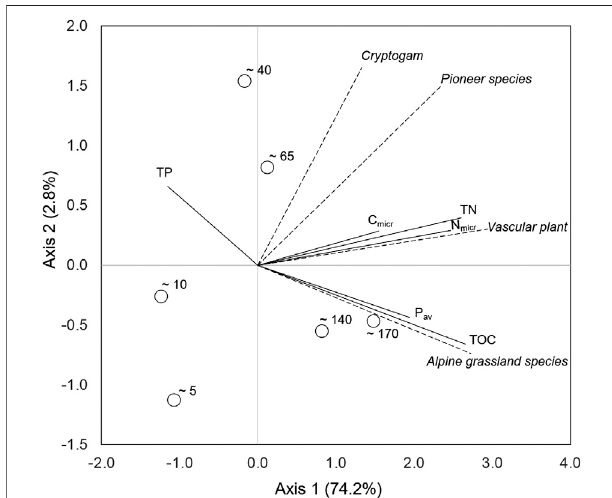
FIGURE 7 | RDA ordination bi-plot showing the distribution of the six chronosequence stages (represented by the centroids of the three replicates per stage) and the relationships between soil properties (solid lines) and vegetation covers (dashed lines). TOC, total organic carbon; TN, total nitrogen; C micr , microbial carbon; N micr , microbial nitrogen; TP, total phosphorus; P av , bicarbonate extractable (available) phosphorus. The variance explained by each axes is provided in